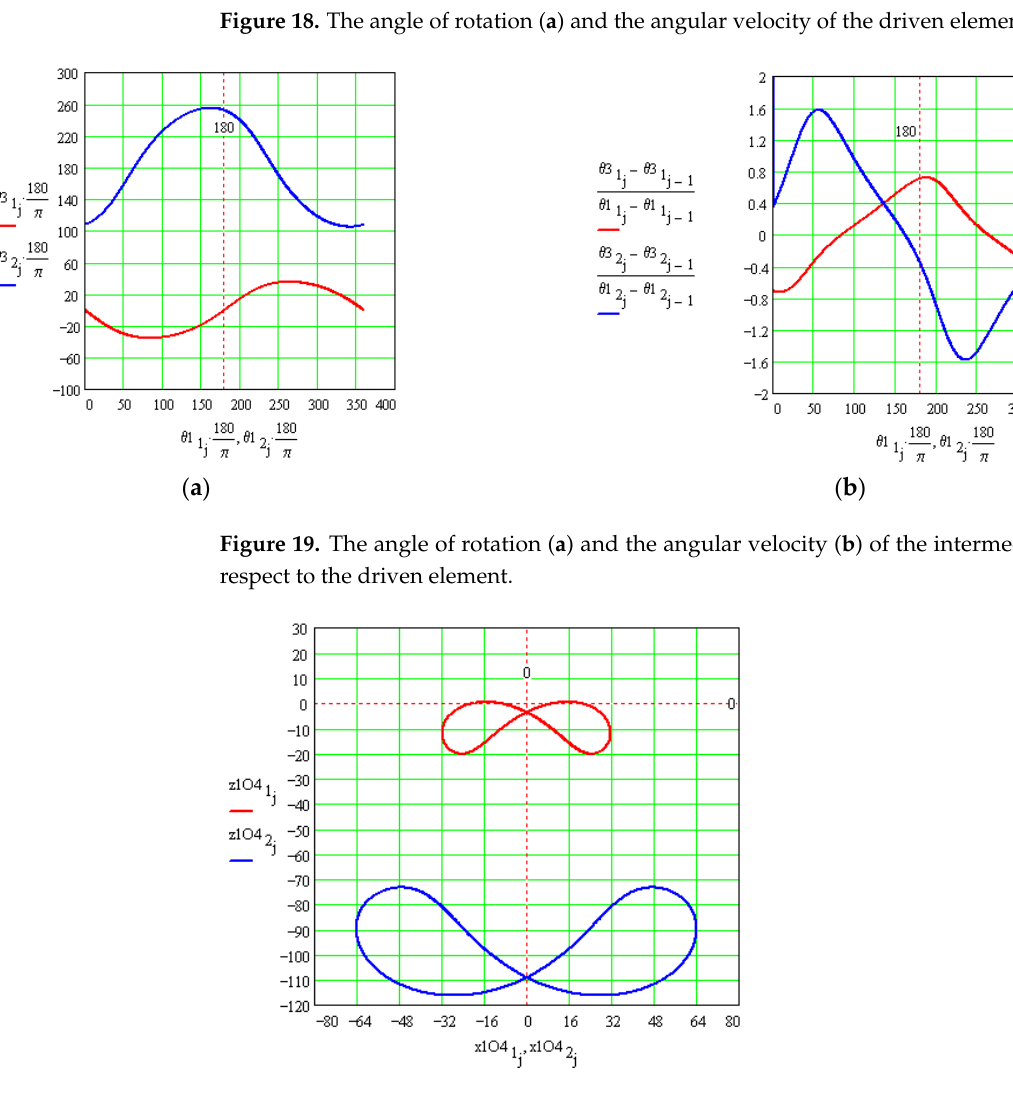
Figure 20. The path of the origins of the frame attached to the intermediate element in the median plane of the channel, for the two assembling possibilities.